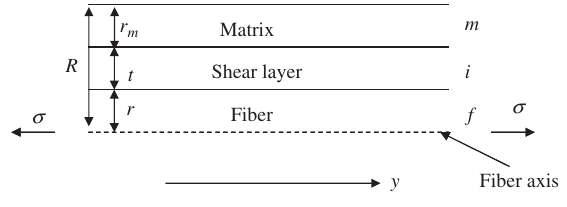
Figure 1 Schematic of the model composite.